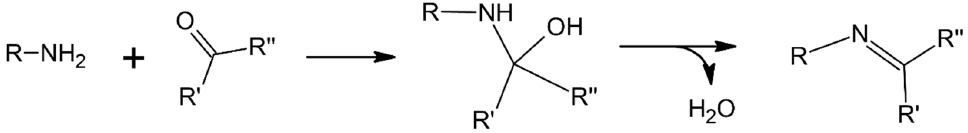
Figure 4. Crosslinking reaction between glutaraldehyde and chitosan, with the formation of an imine after membrane crosslink.